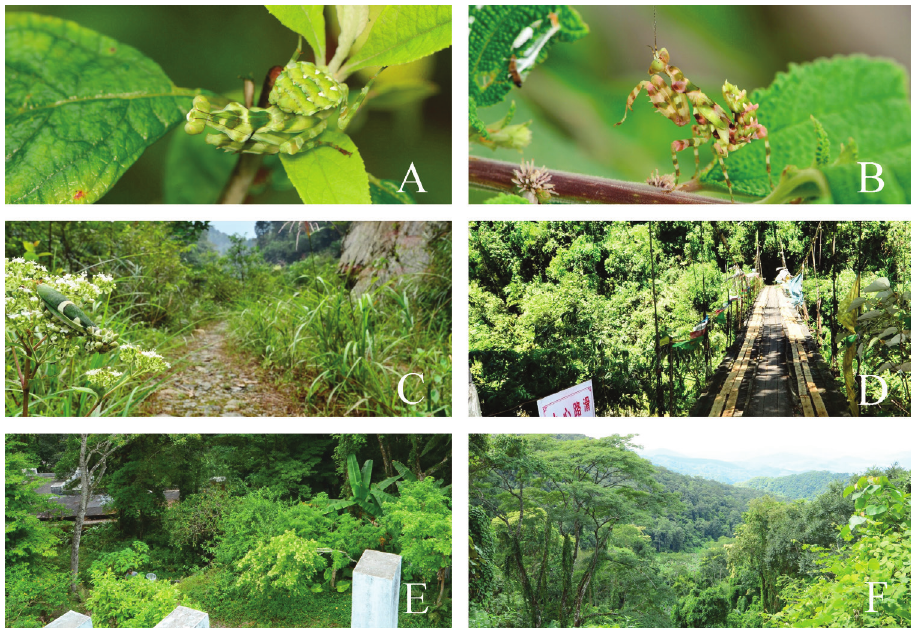
Figure 14. Theopropus spp. nymph in its natural habitat and environment A T. sinecus qiongae ssp. nov. female nymph in Hainan Is B T. xishiae sp. nov. male nymph in Medog C T. sinecus sinecus of Guangxi, Longsheng, Huaping D T. xishiae sp. nov. of Tibet, Medog, Beibeng E T. sinecus qiongae ssp. nov. of Hainan Is. Jianfengling Mt. F T. sp. of Yunnan, Mengla,